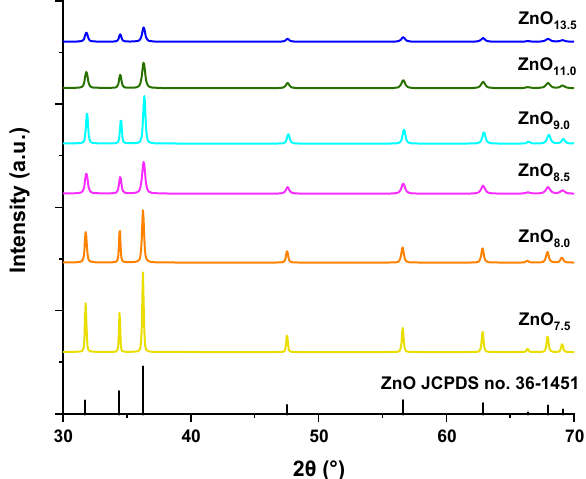
Figure 8. X-ray diffraction patterns of ZnO particles synthesized hydrothermally at different pH: 7.5, 8.0, 8.5, 9.0, 11.0, and 13.5. All compared to the standard ZnO, polycrystalline hexagonal wurtzite (JCPDS card No. 36-1451).